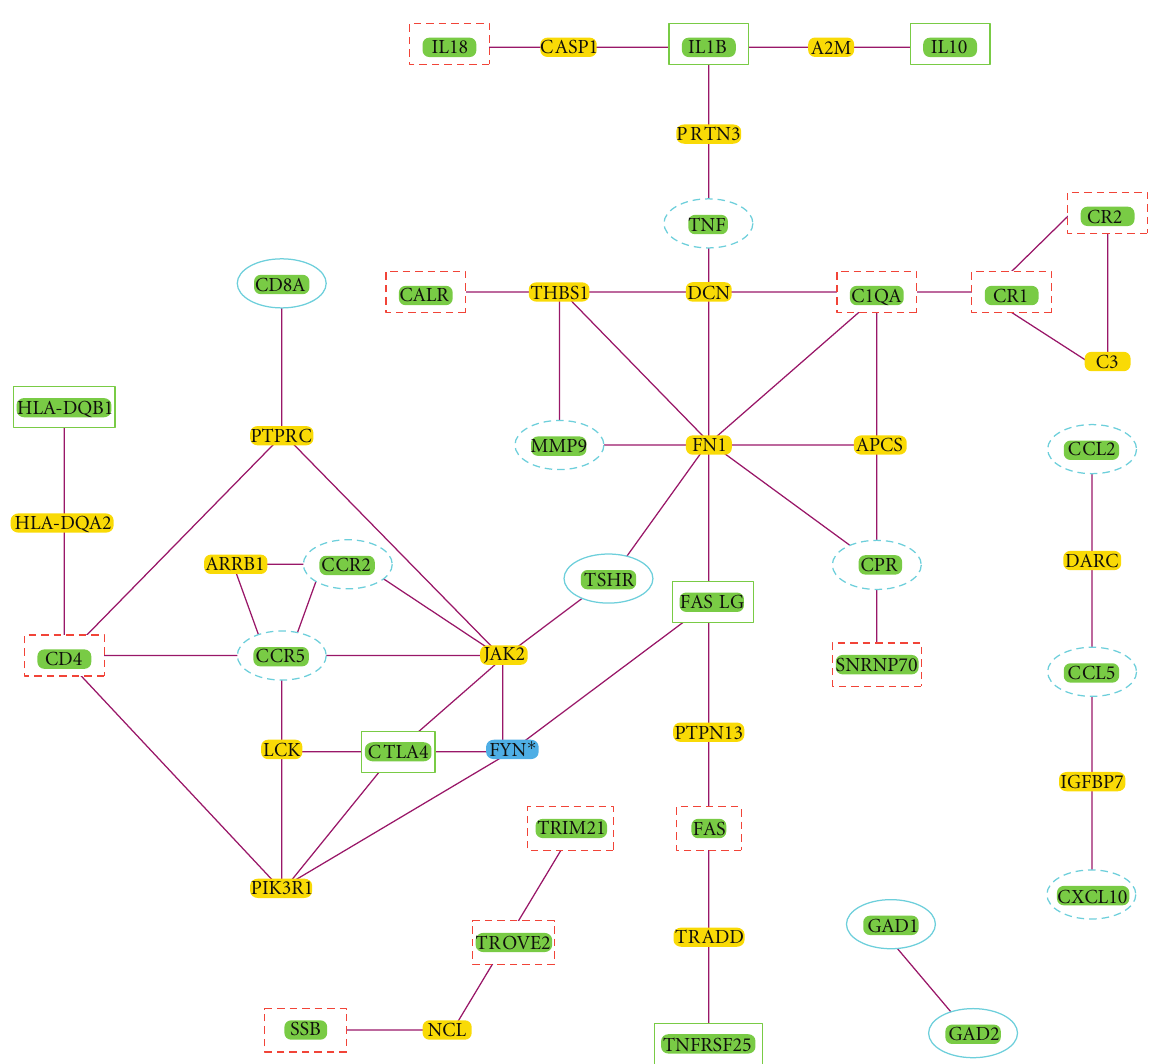
Figure 3: Network analysis of the genes that contribute to the clusters of autoimmune diseases. Solid squares: genes with a contribution higher than 0.1% that are shared by more than one cluster. Dotted squares: genes with a contribution higher than 0.1% from the SLE-SS cluster. Solid ovales: genes with a contribution higher than 0.1% from the T1D-AITD cluster. Dotted ovales: genes with a contribution higher than 0.1% from the RA-MS cluster. The other nodes correspond to significant intermediary ones (the asterisk indicates a nonsignificant intermediary